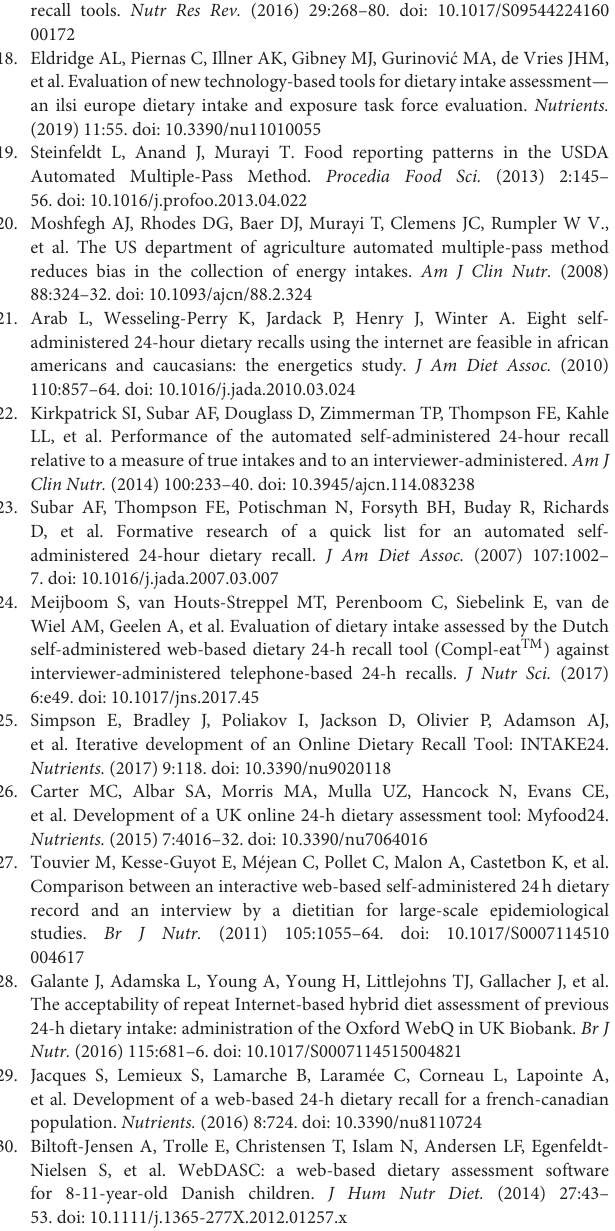
Supplementary Figure 1 | Quantitative experts’ assessment on the MAR24 tool. Supplementary Figure 2 | Qualitative experts’ assessment on the MAR24